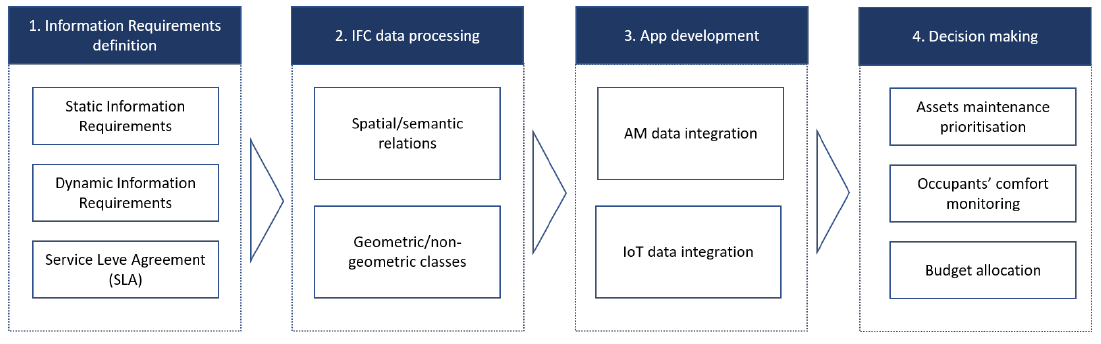
Figure 2. Research